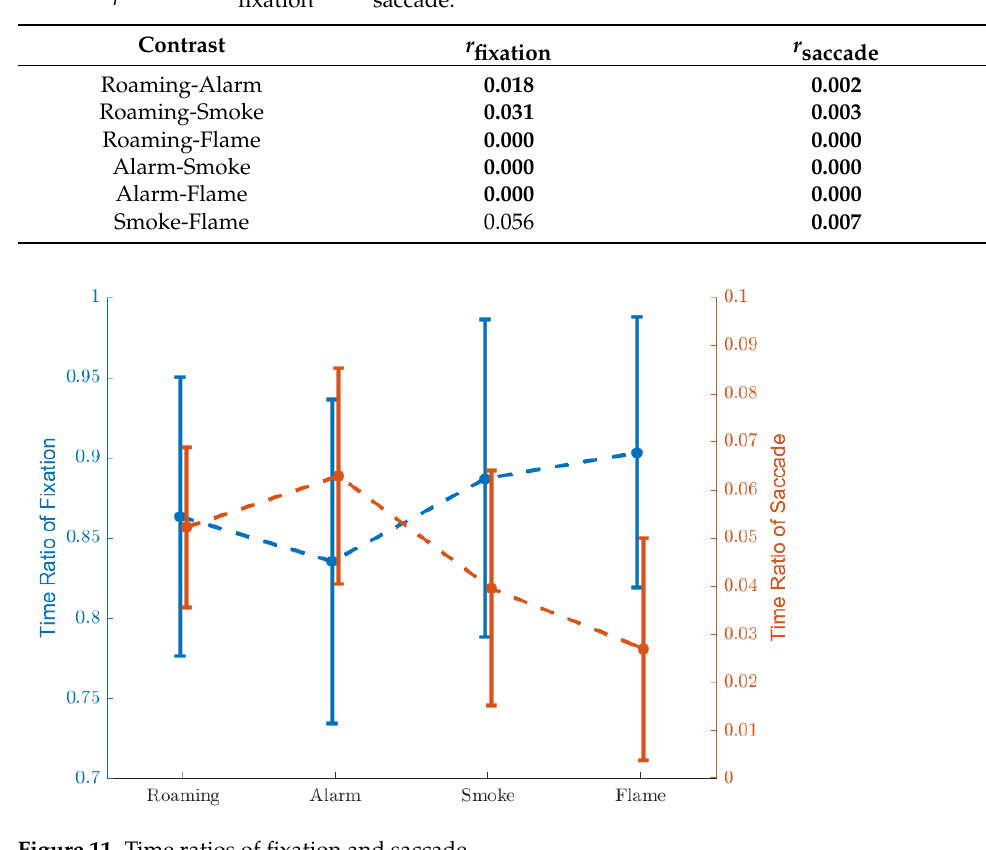
Table 11. p -Values of r fixation and r saccade.